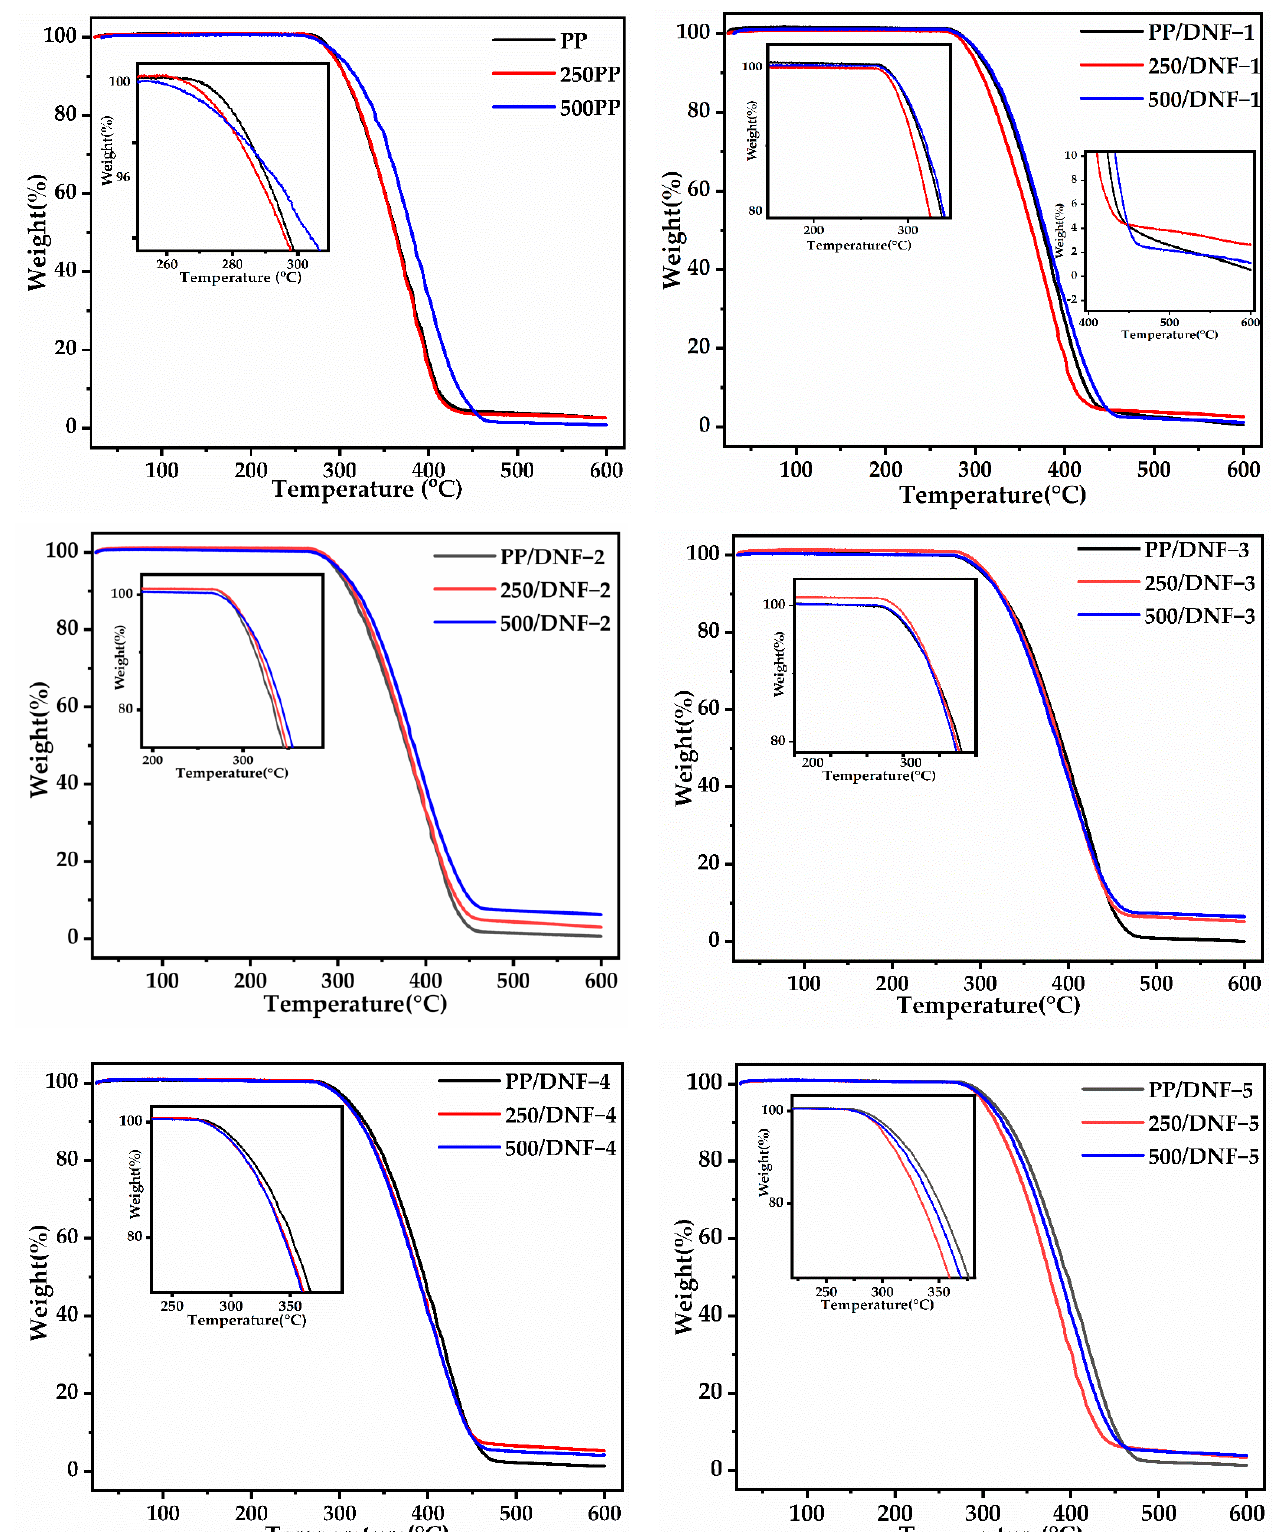
Figure 2. TGA graph of samples before and after 250 h and 500 h weathering. Table 2. Thermal characteristic of the composite samples.